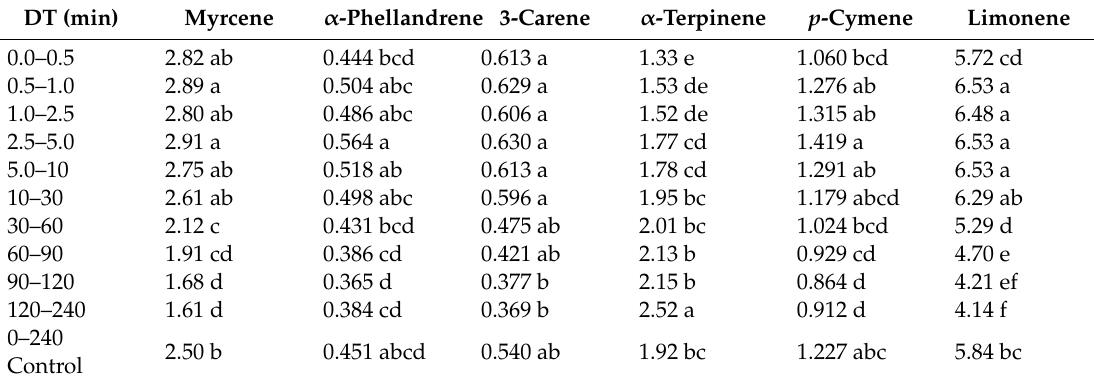
Table 2. Mean concentration (%) of myrcene, α -phellandrene, 3-carene, α -terpinene, p -cymene, and limonene obtained from ten hydrodistillation timeframes (DT) and control (straight 240 min).